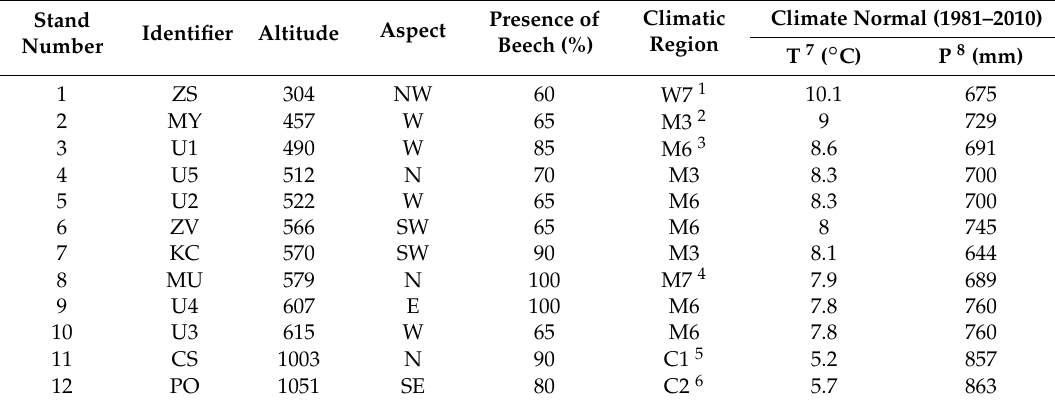
Table 1. The basic characteristics of beech study stands.